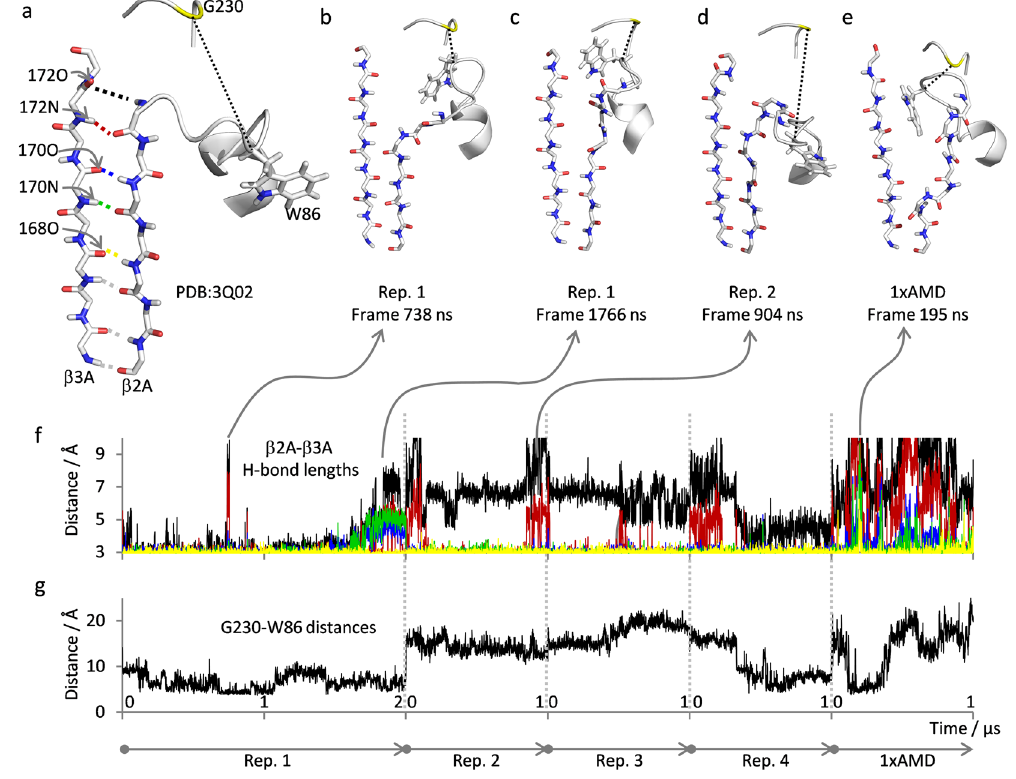
Figure 6. W86-loop dynamics leads to progressive detachment of β 2A from β 3A. Example structures of W86-loop- β 2A- β 3 A configurations are shown from ( a ) the PDB:3Q02 crystal used as basis for simulations and ( b – e ) from the indenticated frames in the simulations on active PAI-1. The W86 sidechain and β 2A and β 3 A backbones are shown as sticks and remaining residues as cartoon. Residue G230 is colored yellow and the distance between C α atoms of G230 and W86 is indicated by the black broken line. Hydrogen-bonds between β 2 A and β 3 A are indicated by dashed colored lines as follows: 172 O:90 N (black), 172 N:90 O (red), 170 O:92 N (blue), 170 N:92 O (green) and 168 O:94 N (yellow). ( f ) β 2A- β 3A hydrogen-bond lengths, according to the color coding in ( a ), are plotted as a function of simulation time consecutively for all simulations on active PAI-1, as indicated. ( e ) the distances between C α atoms of G230 and W86 are plotted as a function of simulation time consecutively for all simulations on active PAI-1, as